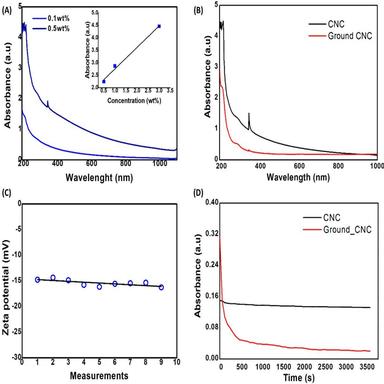
Electrical conductivity (E) and conductivity enhancement (F) of the CNC aqueous solution.